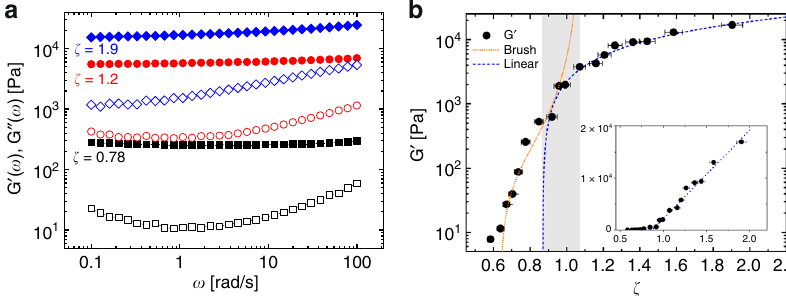
Fig. 3 Oscillatory shear experiments on dense microgel suspensions. a G ′ ( ω ) (full symbols) and G ″ ( ω ) (open symbols) as a function of frequency ω for different packing fractions, ranging from marginally jammed to deeply overpacked. b G ′ ( ω = 1.2 rad/s) as a function of packing fraction ζ fi tted with the Brush model (orange dotted line) at lower ζ and with a linear function G ′ = 17 kPa × ( ζ − ζ c ), dashed line for ζ ≥ ζ c = 0.87. The shaded area marks the crossover between the regime controlled by corona compression to the one governed by core – core interactions. Inset: Linear representation of the same data. The estimated error in ζ shown in panel ( b ) is size R , decorated by polymer brushes, of thickness L 0 ≃ R tot − R ,